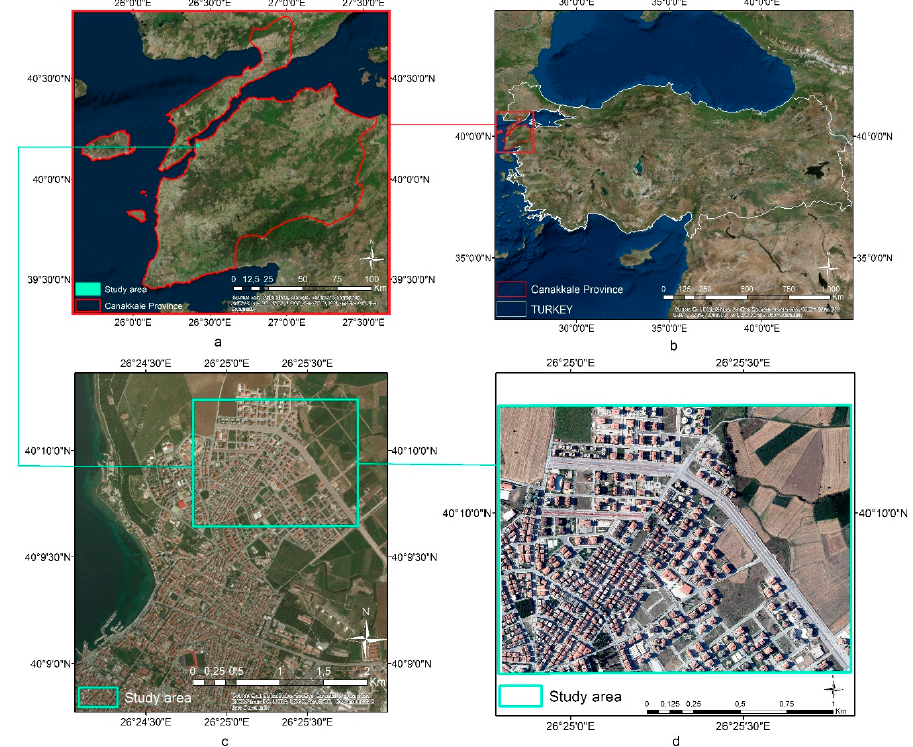
Figure 1. Study area: ( a – c ) Google Earth imagery, ( d ) ortho-mosaic image.